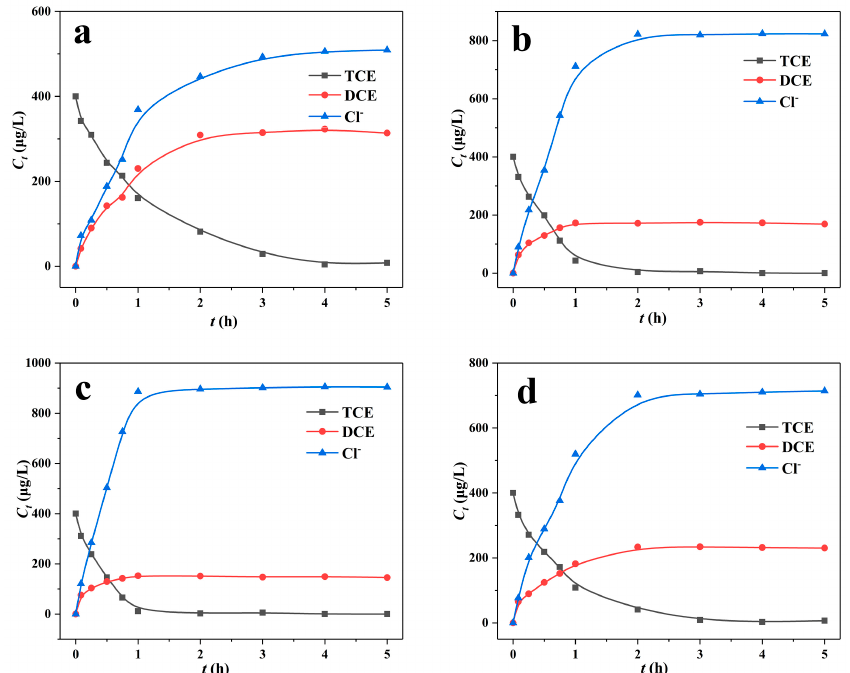
Figure 5. The concentrations of chloride ions for Ni-nZVI degradation with different Ni contents: ( a ) 0.5% Ni-nZVI; ( b ) 3% Ni-nZVI; ( c ) 5% Ni-nZVI; ( d ) 10% Ni-nZVI.